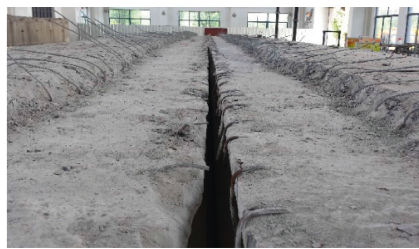
Figure 3: Hollow slab girder.